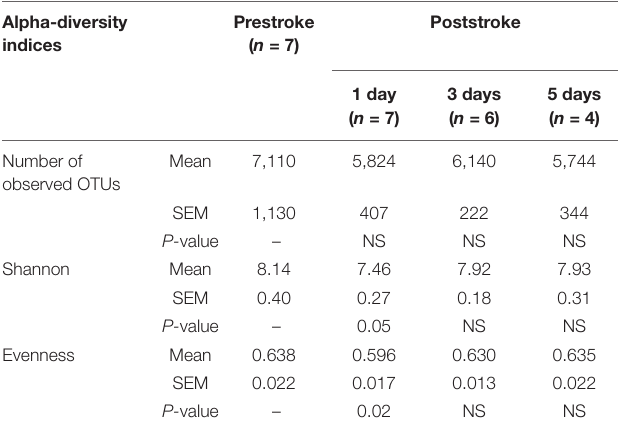
TABLE 1 | Alpha-diversity was changed during the acute stage of ischemic stroke in a pig model. Alpha-diversity indices